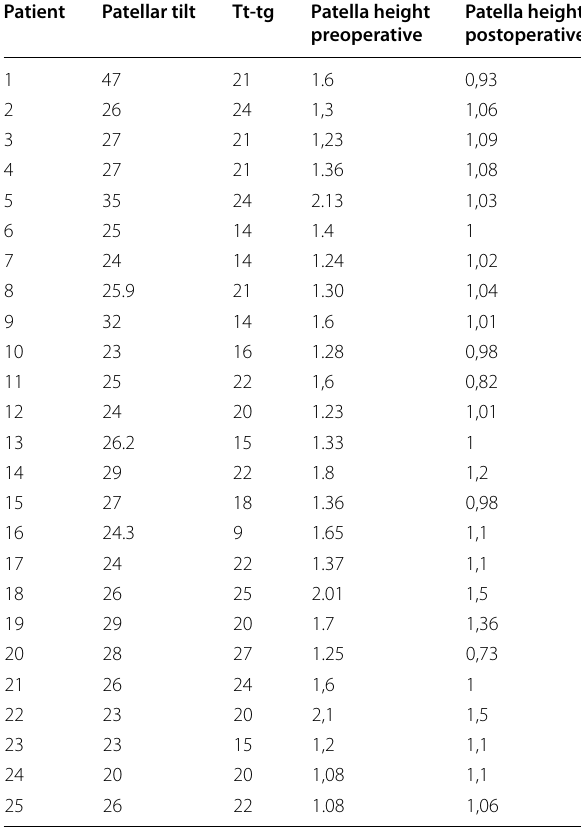
Table 5 Values of Patellar Tilt (irregular > 20°), TT-TG (pathological > 20 mm) and preoperative and postoperative Patella height using Caton Deschamps Index (irregular > 1.4) Patient Patellar tilt Patella height